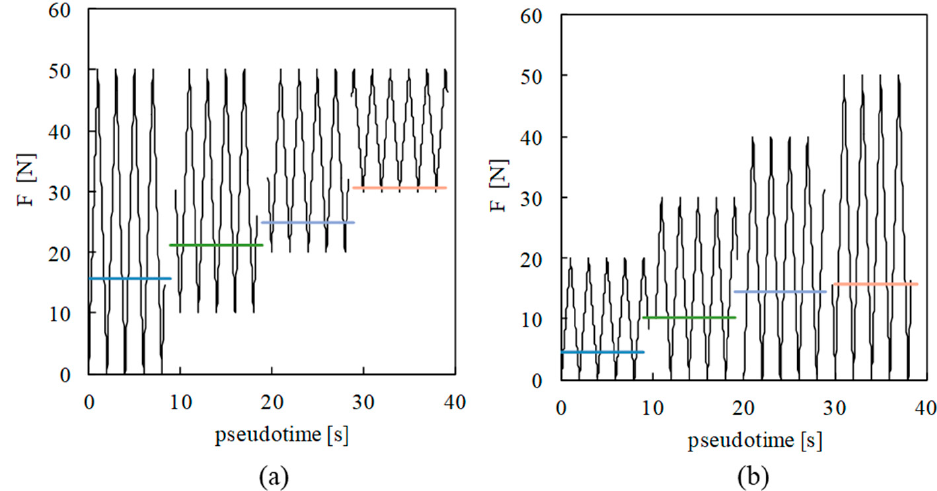
Figure 4. Predicted crack opening load: ( a ) fixing the maximum load, F max . ( b ) Fixing the minimum load, F min .